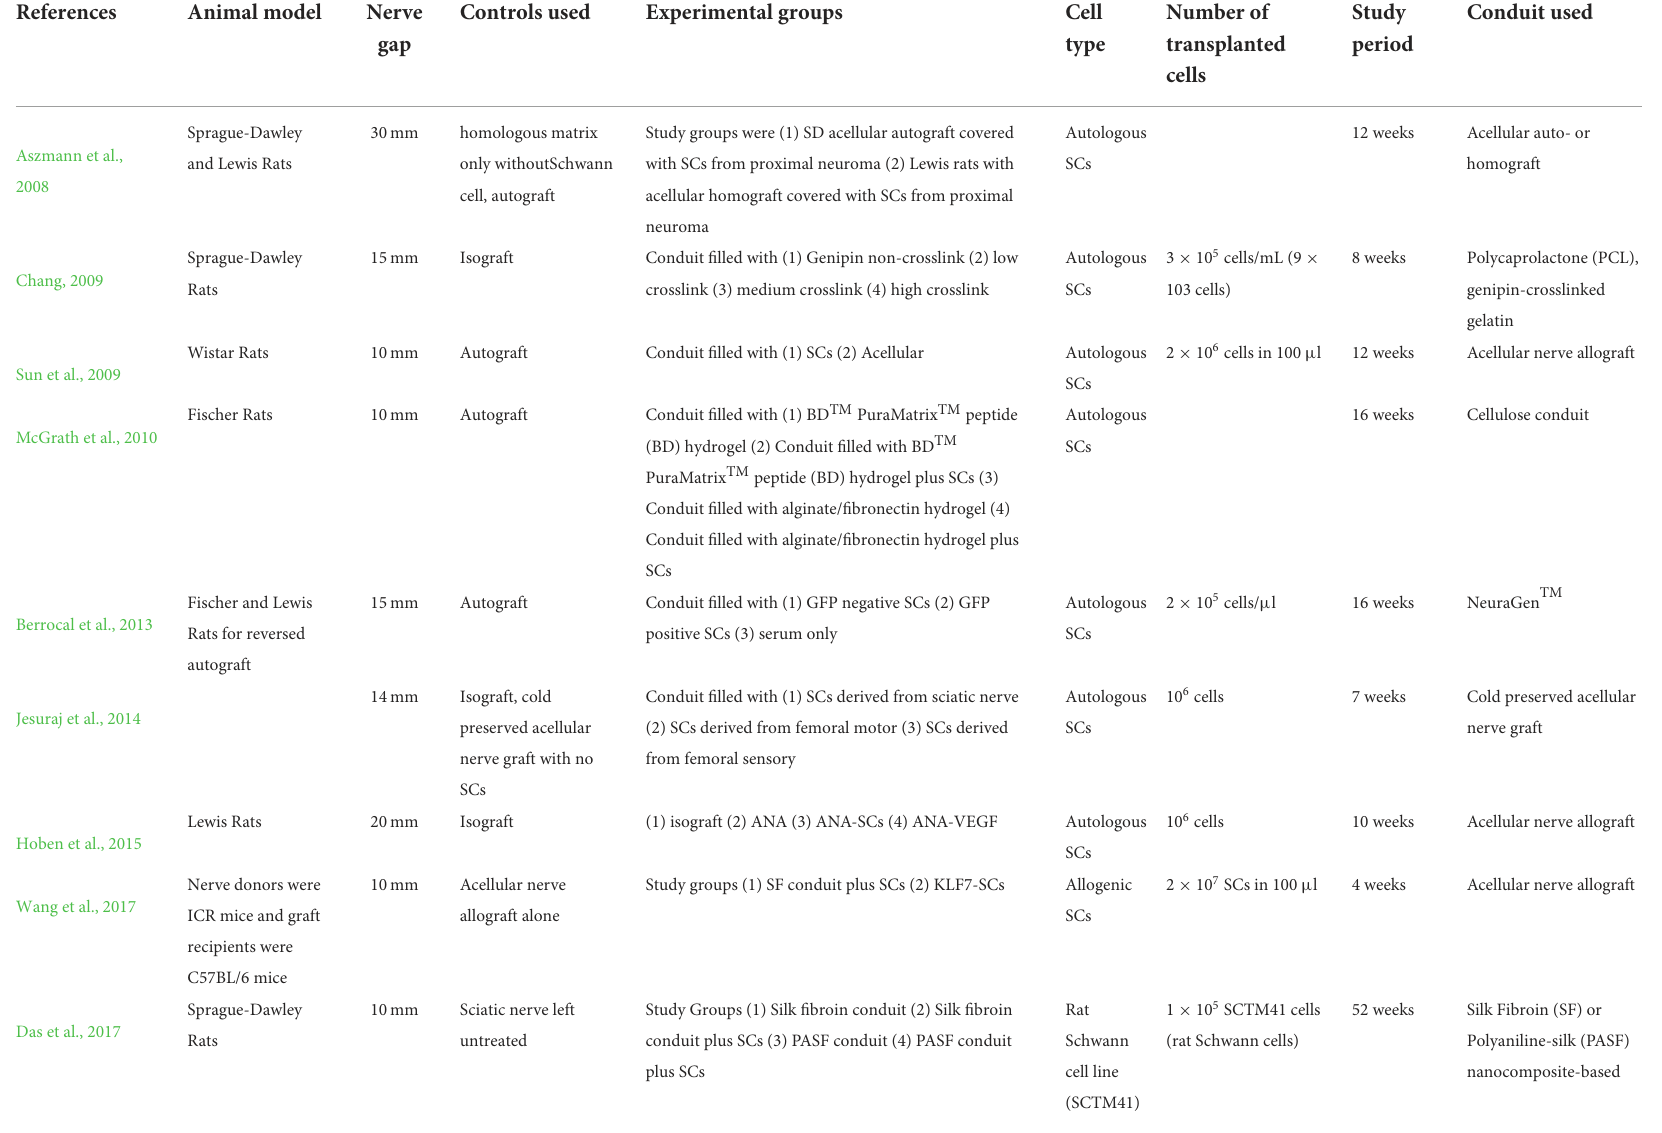
TABLE 1 Autologous Schwann cell transplantation for long-gap peripheral nerve